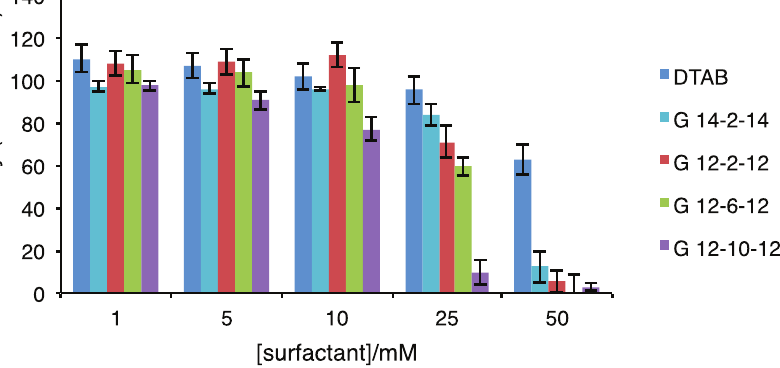
Figure 1. Viability of NCTC 2544 cells after 24 h of surfactant exposure. Cell viability values are presented as mean 6 SD of a characteristic profile (3 repetitions) selected from 5 independent